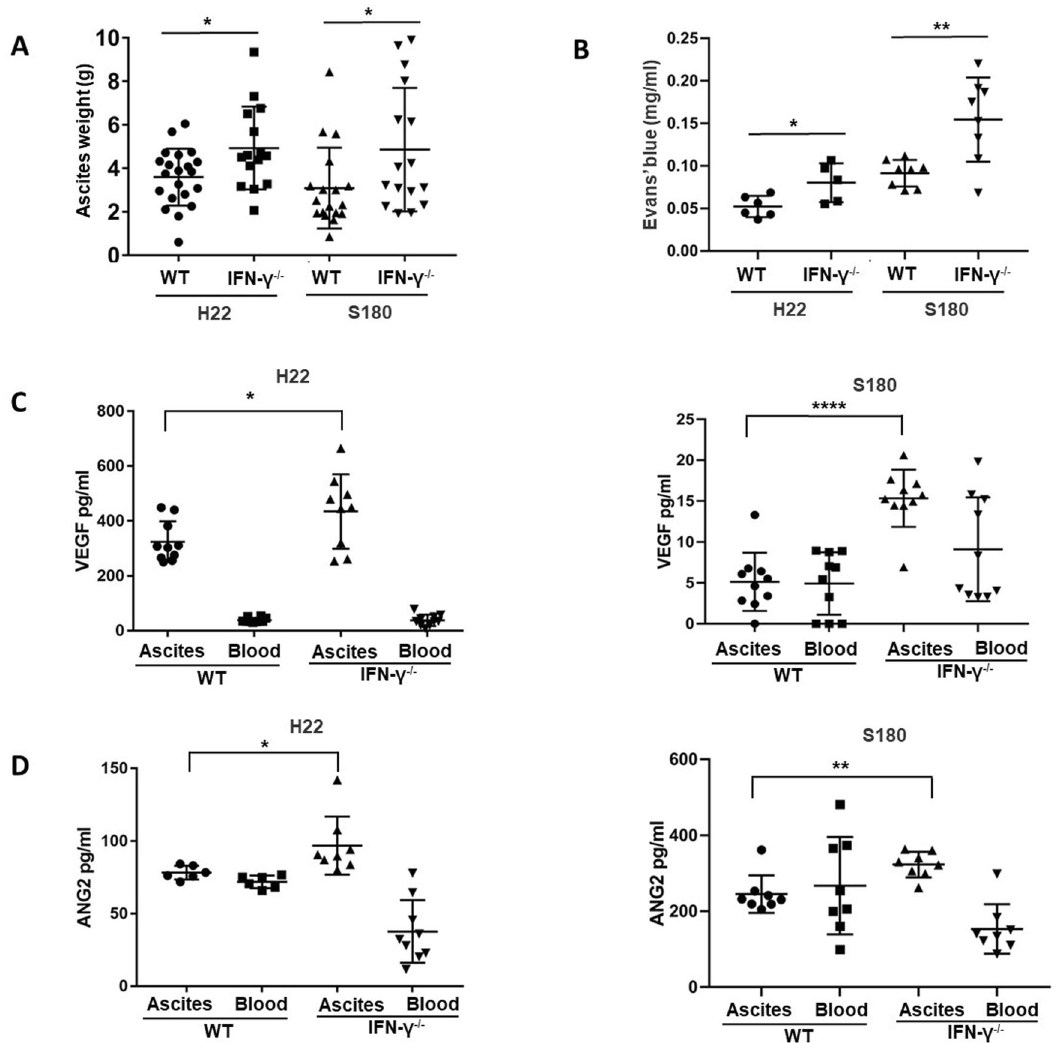
B peritoneal permeability assay demonstrated IFN- γ de fi ciency increased peritoneal permeability through determining Evan ’ s blue; C the concentration of VEGF in peritoneal fl uid and corresponding blood of WT or IFN- γ − / − mice with malignant ascites; left panel: H22; right panel: S180; D the concentration of angiotensin-2 in peritoneal fl uid and corresponding blood of WT or IFN- γ − / − mice with malignant ascites; left panel: H22; right panel: S180. The difference between two groups was determined by t test. * p ≤ 0.05, ** p ≤ 0.01, *** p ≤ 0.001, **** p ≤ 0.0001, ns no signi fi